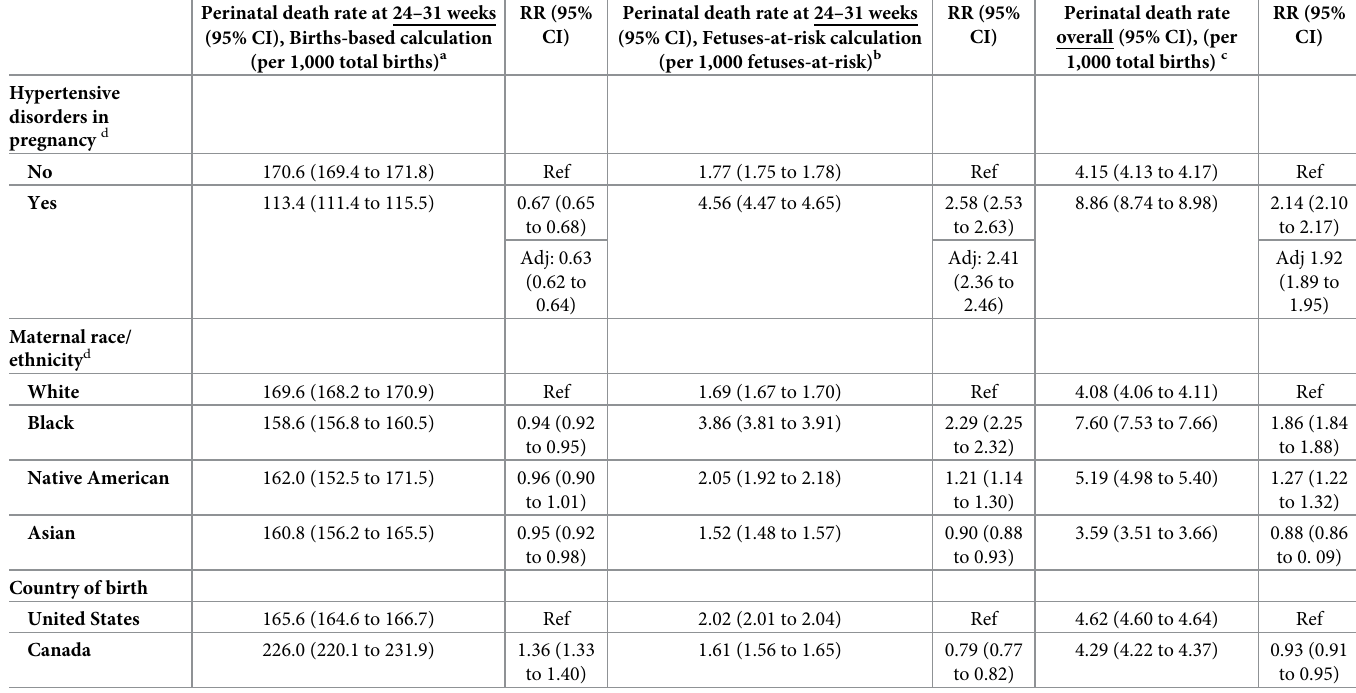
Table 2. Comparisons of rates of perinatal death at 24–31 weeks’ gestation and overall among singletons with no congenital or chromosomal anomaly, 2006–2015. Perinatal death rate at 24–31 weeks (95% CI), Births-based calculation (per 1,000 total births) a